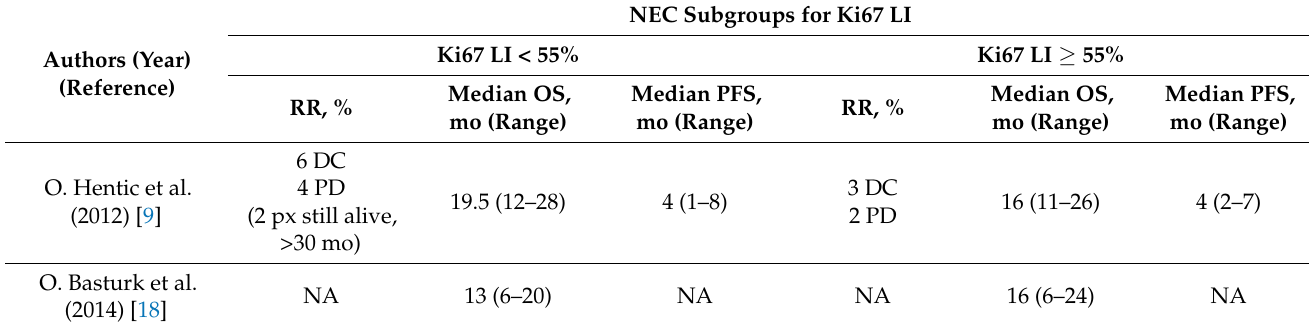
Table 3. Treatment response and outcomes in patients with neuroendocrine carcinoma (NEC) and low Ki67 labeling index (LI) vs. high Ki67